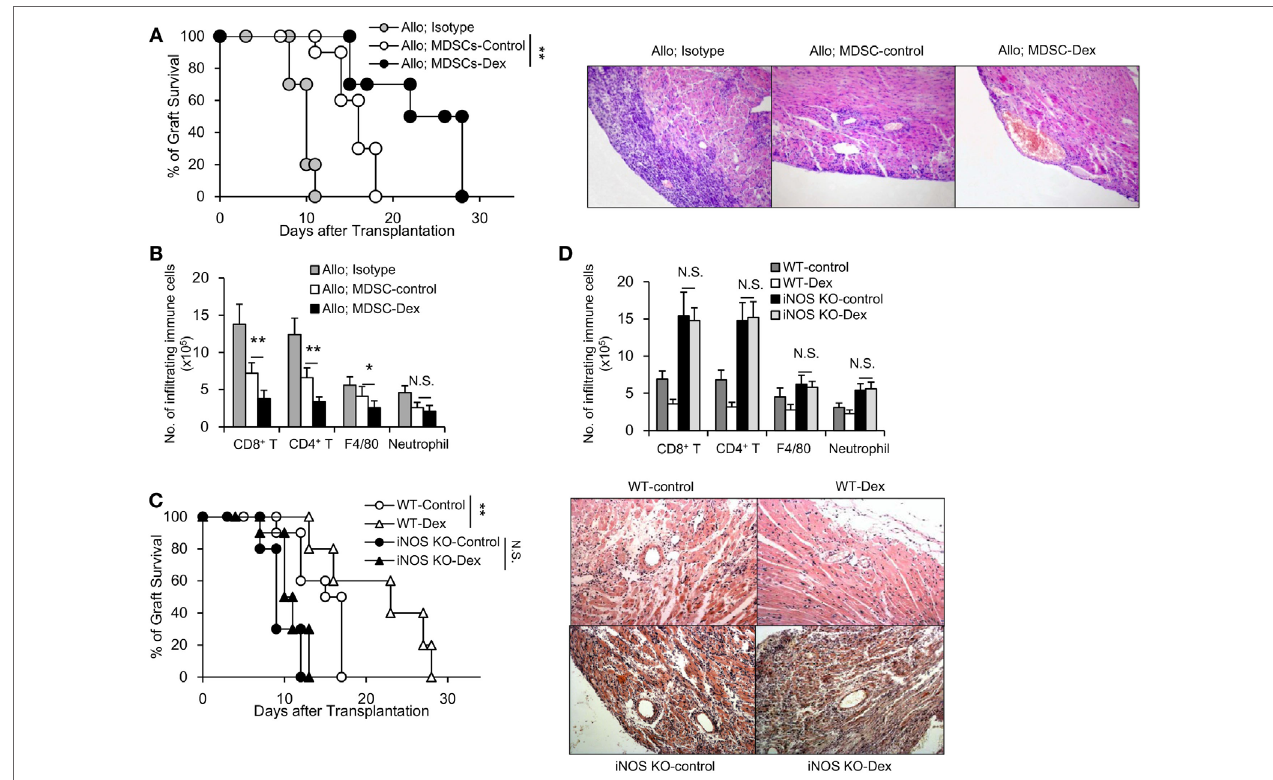
FigUre 3 | Adoptive transfer of granulocyte macrophage colony stimulating factor (GM-CSF) + dexamethasone (Dex)-induced Myeloid-derived suppressor cells (MDSCs) prolongs cardiac allograft survival in an iNOS-dependent manner. (a) Cardiac allograft survival (BALB/c donor hearts to C57BL/6J recipient mice) from mice transferred with sorted CD11b + Gr-1 int/low MDSCs (3 × 10 6 per mouse, i.v.) induced by GM-CSF or GM-CSF + Dex immediately after cardiac allograft transplantation was monitored ( n = 8 per group), and H&E staining of representative sections at postoperative day 7 from mice transferred with MDSCs were shown. (B) Numbers of infiltrating immune cells in cardiac allografts were assessed by flow cytometry. (c) Deficiency of iNOS reversed the protective function of Dex-induced MDSCs on cardiac allograft in recipient mice ( n = 8 per group). (D) The infiltration of immune cells in cardiac allografts were analyzed in WT or iNOS knockout (KO) mice transferred with MDSCs induced by GM-CSF or GM-CSF + Dex. * P < 0.05, ** P < 0.01, N.S., not